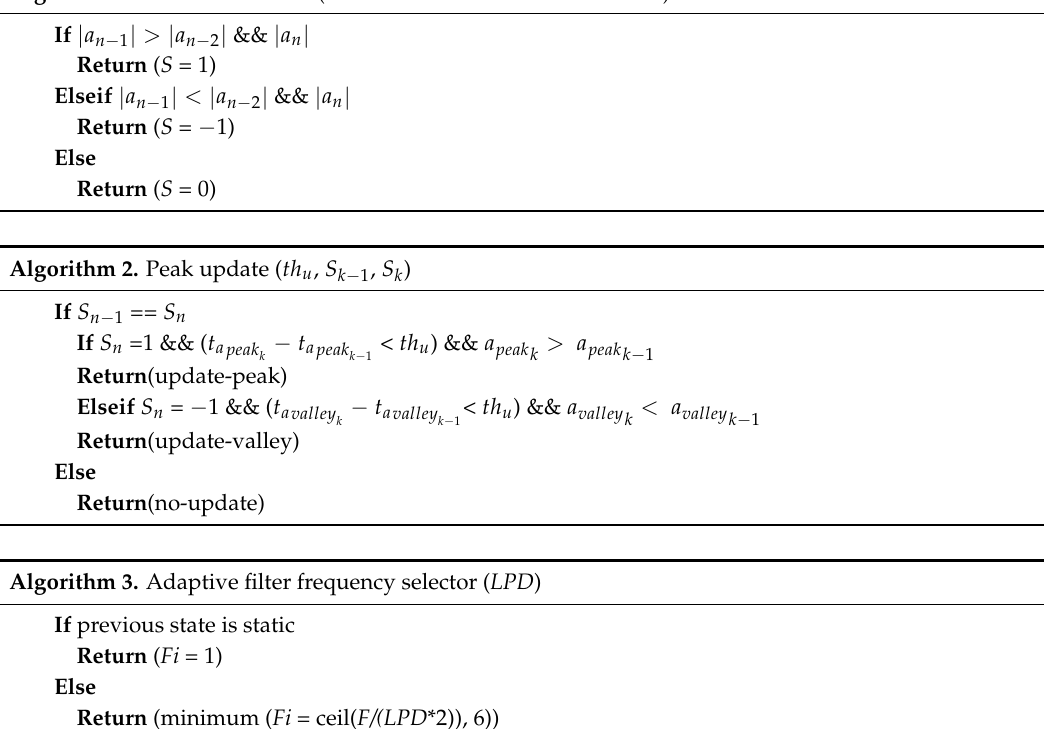
Algorithm 1. Detect candidate (window of last three accelerations)